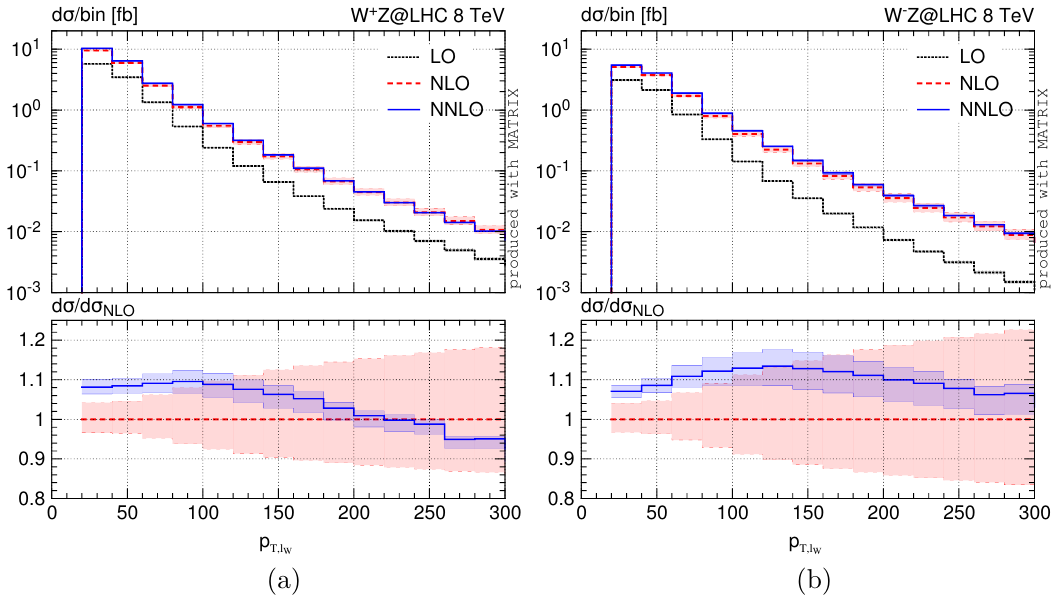
Figure 12 . Distributions in the transverse momentum of the lepton associated with the W decay, but separately for (a) W + Z and (b) W (cid:0) Z production (corresponding to the ratio in (cid:12)gure 11